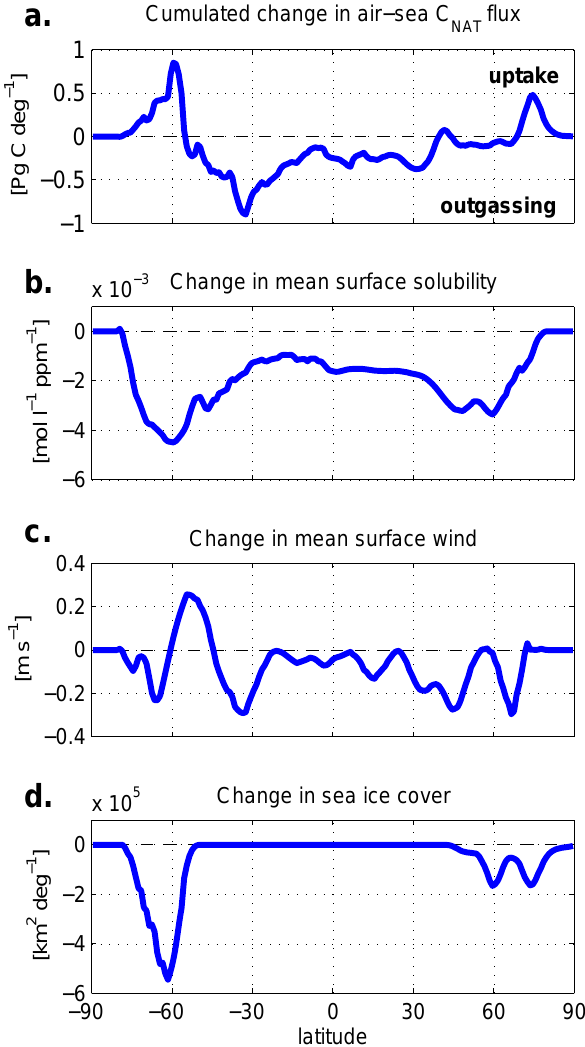
Fig. 1. Latitudinal distribution of (a) difference (EXP3-EXP1) in time-integrated air-sea C nat fluxes for the 1850-2099 period, dif- ference between EXP3 and EXP1 in (b) surface solubility of CO 2 , (c) surface wind speed, and (d) sea ice cover computed at the end of the 21st century